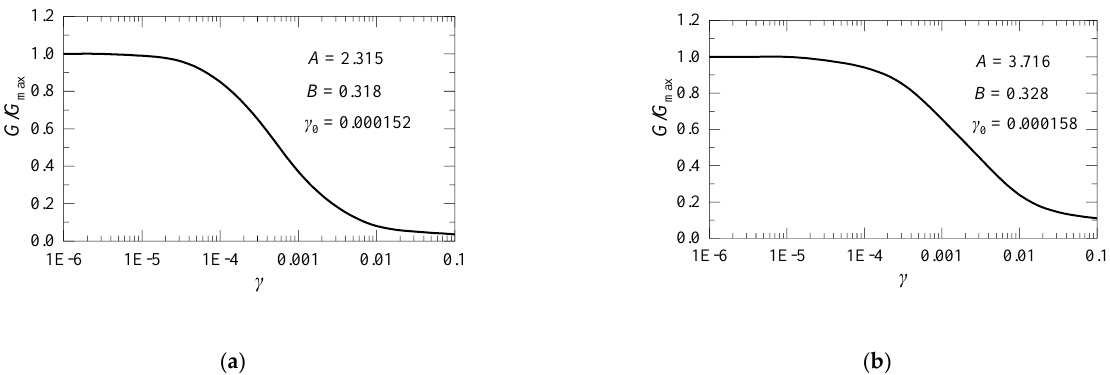
Figure 10. Stiffness parameters of soil: ( a ) Shear modulus ratio-shear strain curve of sand; ( b ) Shear modulus ratio-shear strain curve of clay.